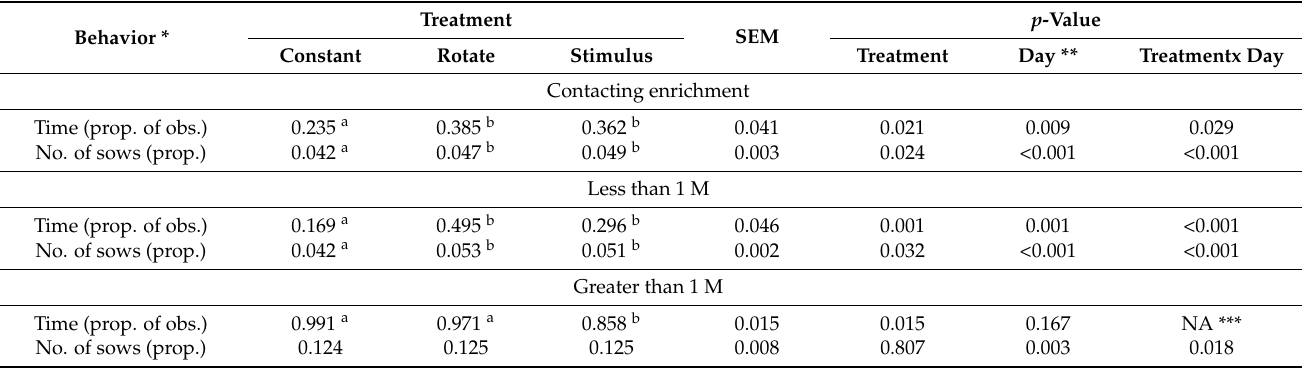
Table 2. Effects of enrichment treatment, day of observation and their interaction on time spent (proportion of observations) and number of sows (proportion of sows) in contact with enrichment, less than 1 M or greater than 1 M from